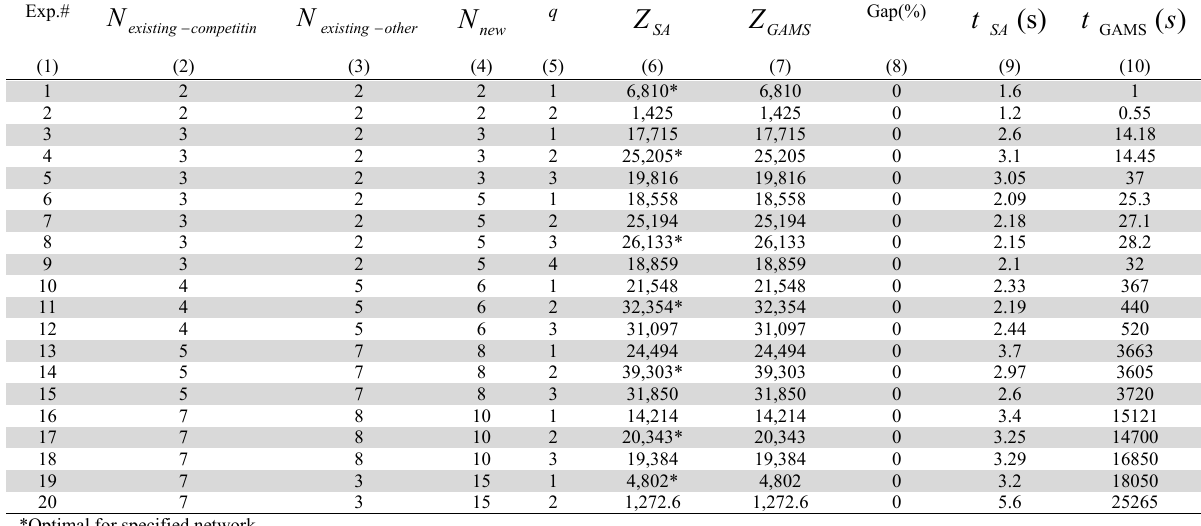
Performance of SA compared against GAMS for test